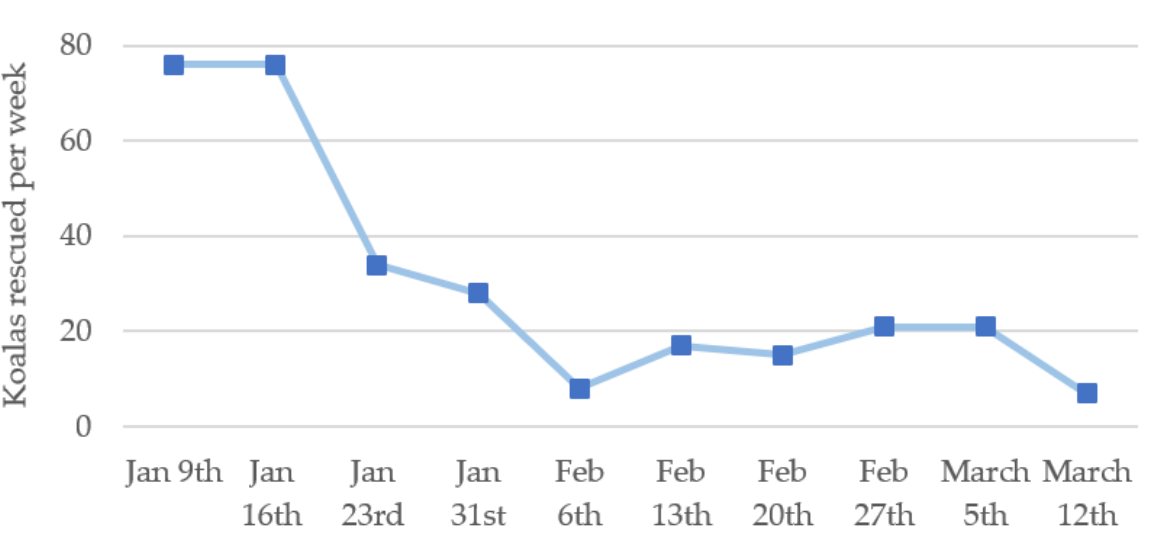
Figure 1. Number of recorded koala rescues per week. First recorded koala rescue in this study occurred on 9 January 2020. Fire progression ceased on 13 January, followed by declaration of all fires as contained, and safe, on 21 January and 6 February, respectively.